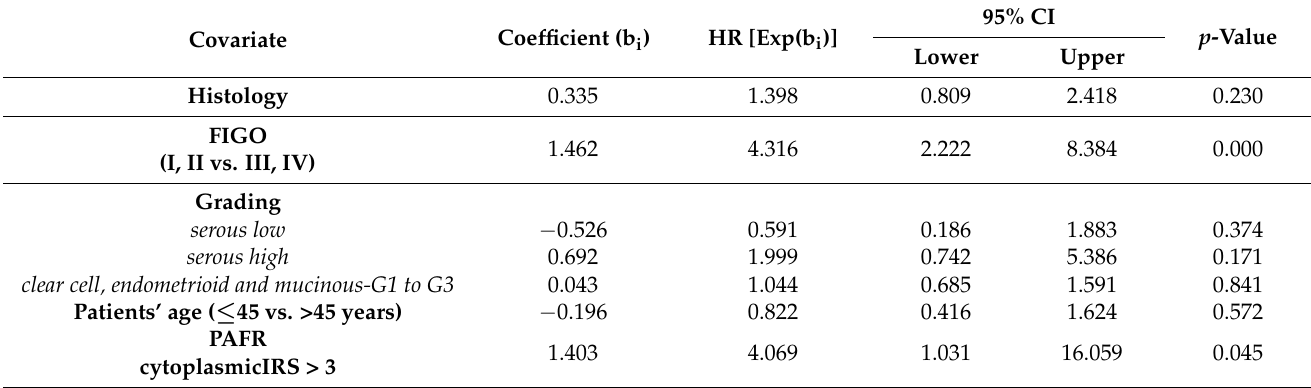
Table 3. Multivariate analysis of clinicopathological parameters and cytoplasmic PAFR